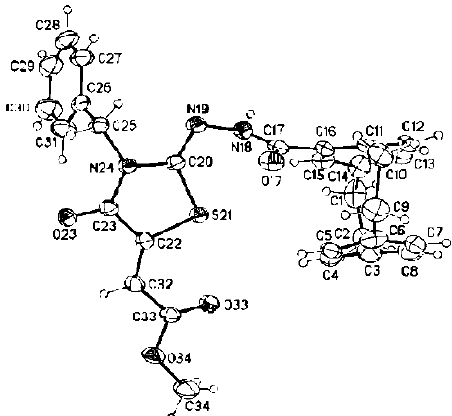
Figure 7. Molecular structure of compound 3b identified according to IUPAC nomenclature as methyl ( E )-2-(( E )-2-(2-(1,4(1,4)-dibenzen-cyclohexaphane-12-carbonyl)hydrazinylidene)-3-benzyl-4-oxothiazolidin-5-ylidene)acetate.